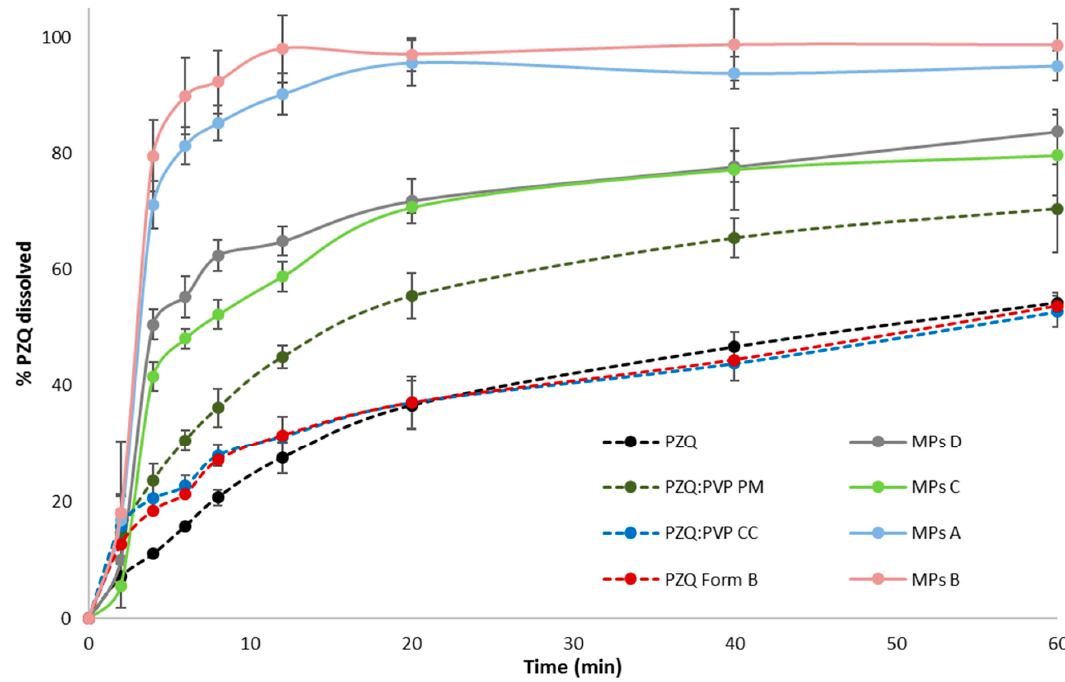
Figure 8. Dissolution profiles of the activated materials and microparticles, in comparison to raw PZQ and a PZQ:PVP physical mixture.